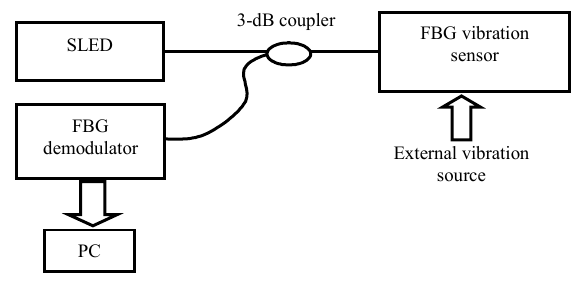
Fig. 4 Principle schematic of the FBG vibration